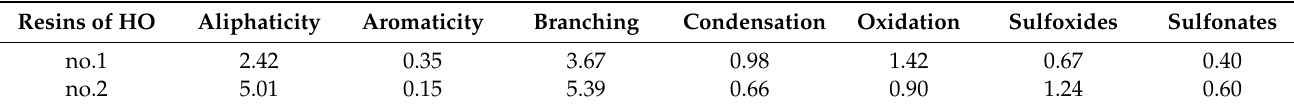
Figure 3. Fourier IR spectra of DMF extracts of the resins of HO nos. 1 ( а ) and 2 ( b ). Table 4. Spectral coefficients of DMF extracts from resins.